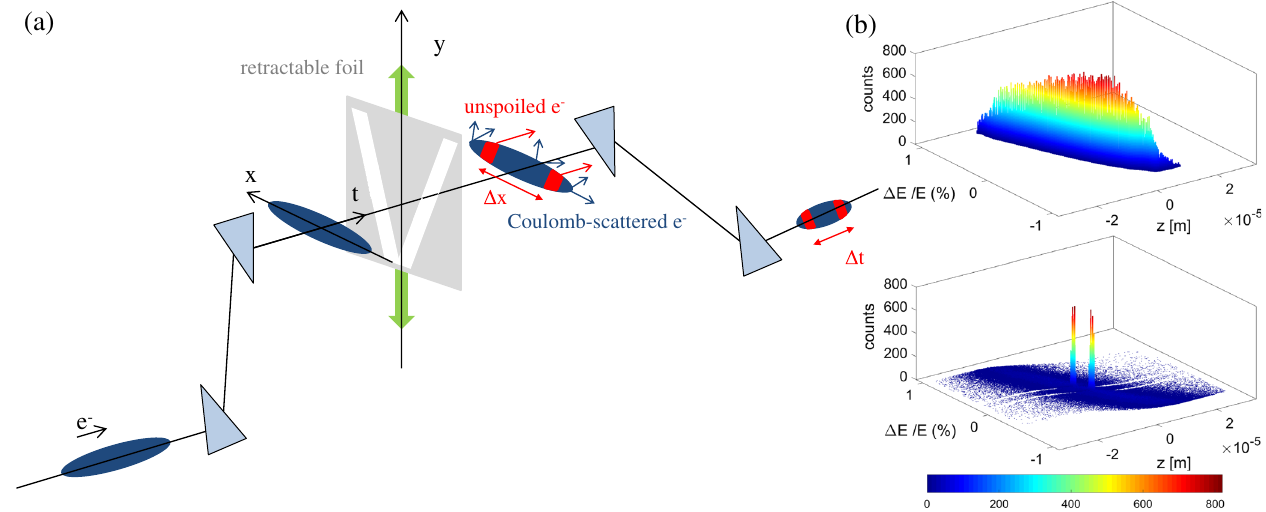
FIG. 1. Scheme of the method to generate two-color FEL pulses from two unspoiled beam slices and a large energy chirp. (a) A V- shaped slotted foil is situated at the center of a magnetic chicane, spoiling the emittance of the beam except for the slices going through the holes. (b) 2D histogram of a bunch with a large energy chirp at the entrance of the undulators for two different cases: (Top) no slotted foil is placed in the beam path, the beam has a flat current profile and a large-bandwidth XFEL pulse is generated. (Bottom) a slotted foil is placed on the beam path. All particles that do not go through the slots suffer scattering and the distribution is smeared out. Only the two bunch slices that pass through the slots are not scattered and form two current spikes that lase along the undulators. Two XFEL pulses of different colors are generated from this